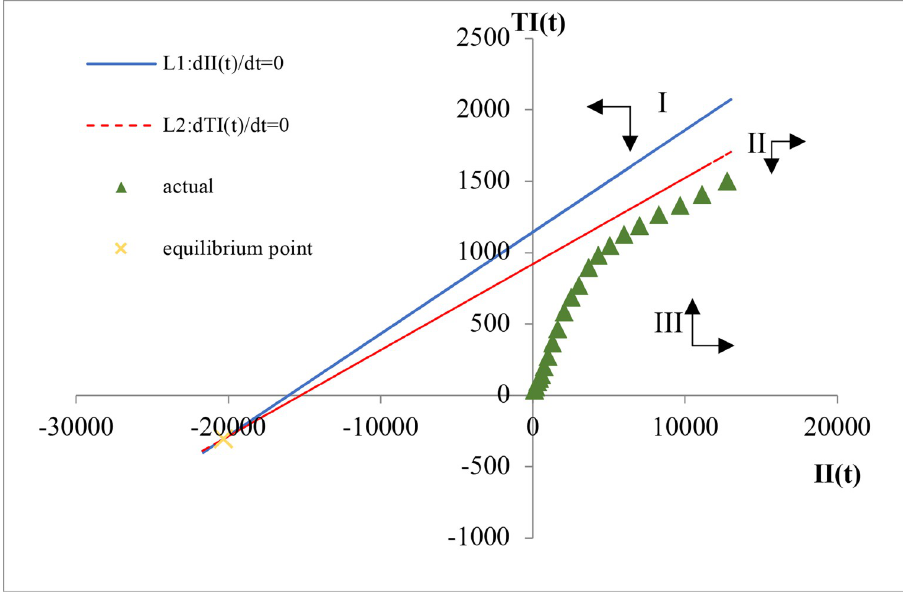
Fig 6. Evolutionary trend of II and